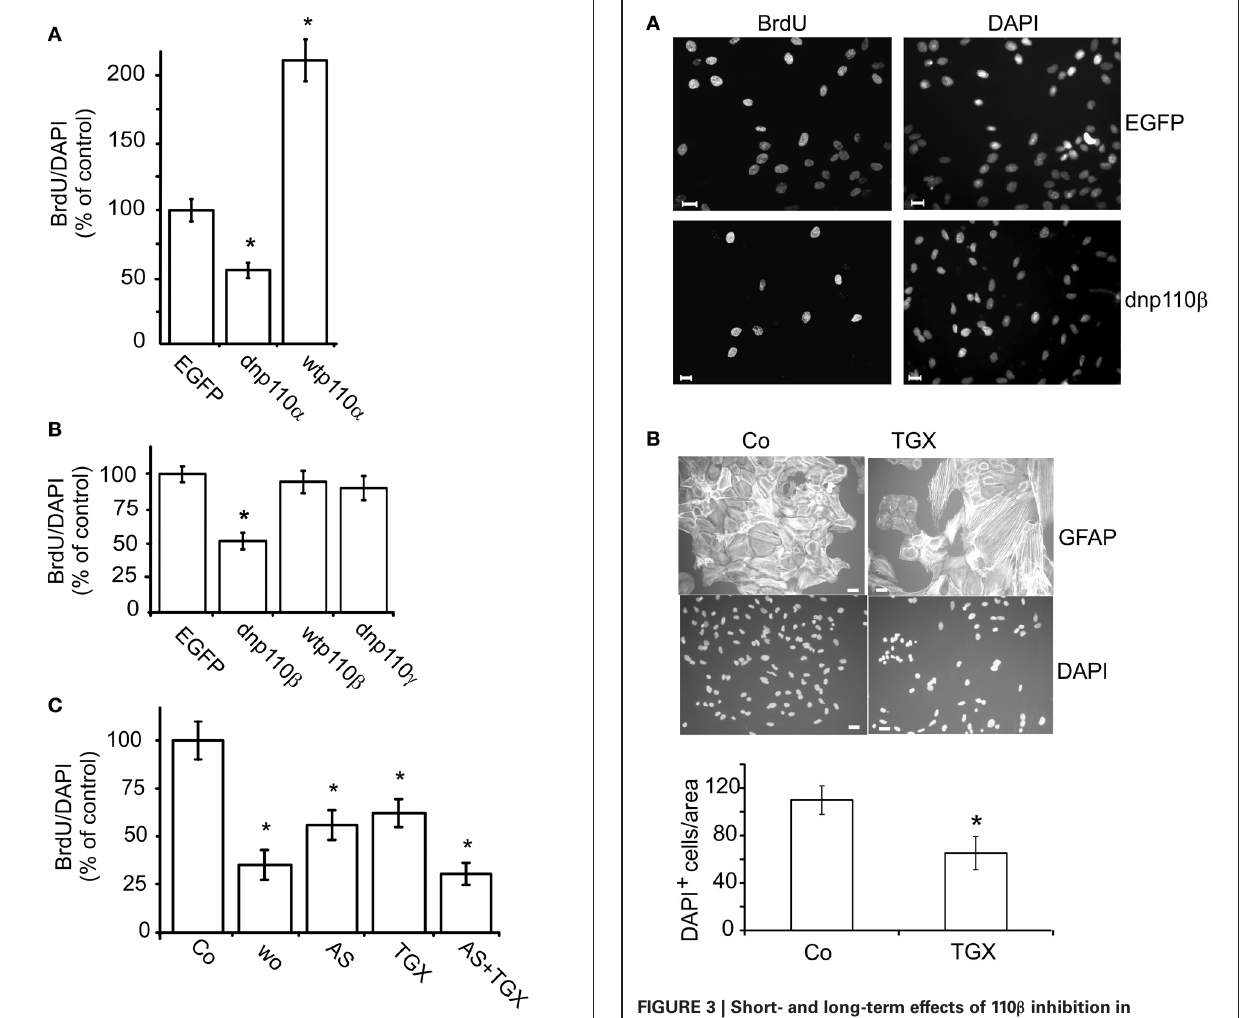
it ( Figure 5A ). Within 1 min after re-addition, FBS